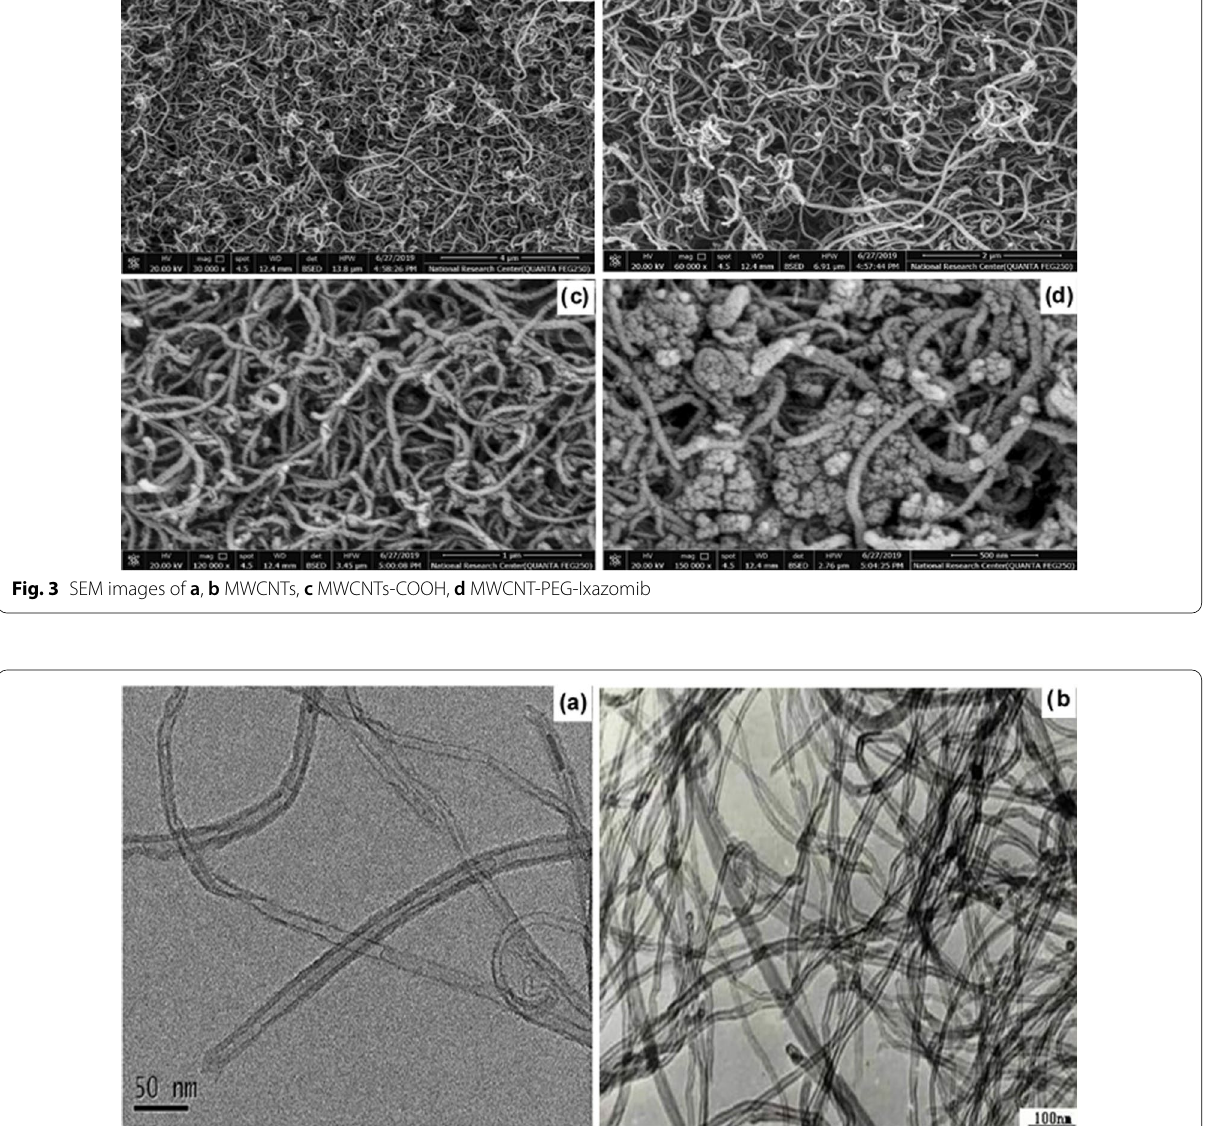
Fig. 4 HRTEM images of MWCNTs a at 50 nm and b at 100